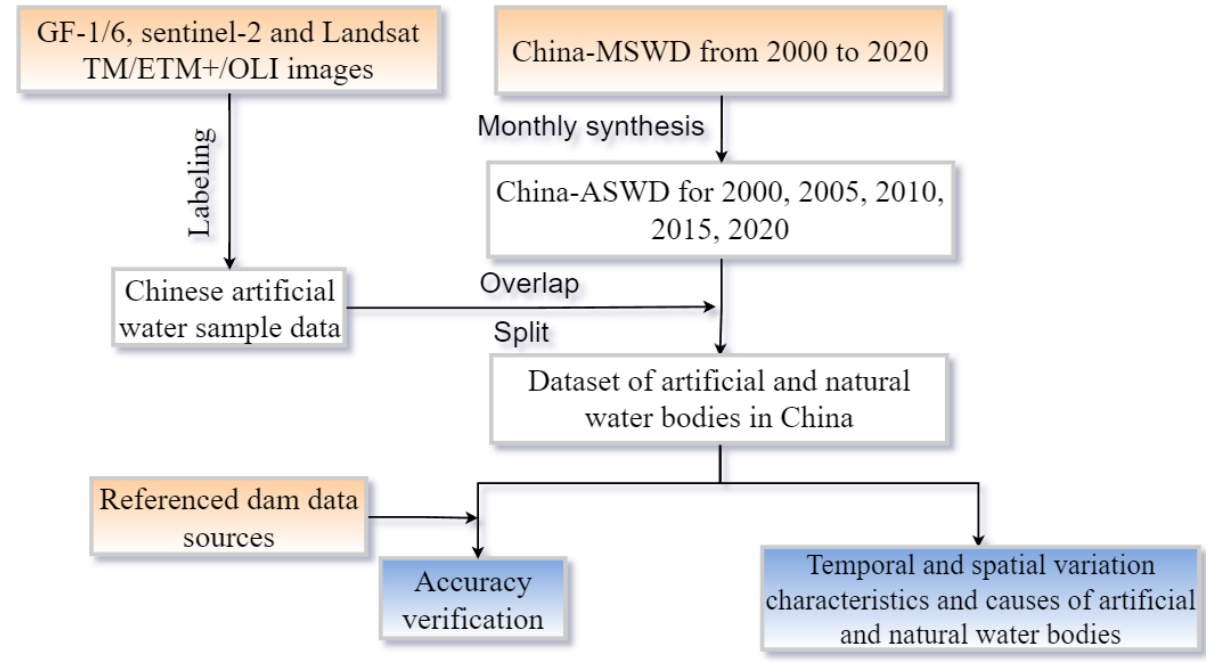
Figure 2. Diagram of the research